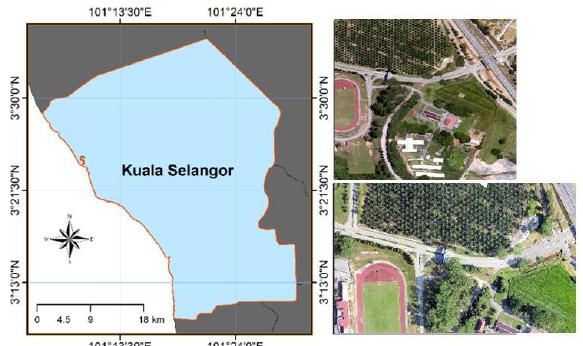
Figure 1. The study area located over UPM.